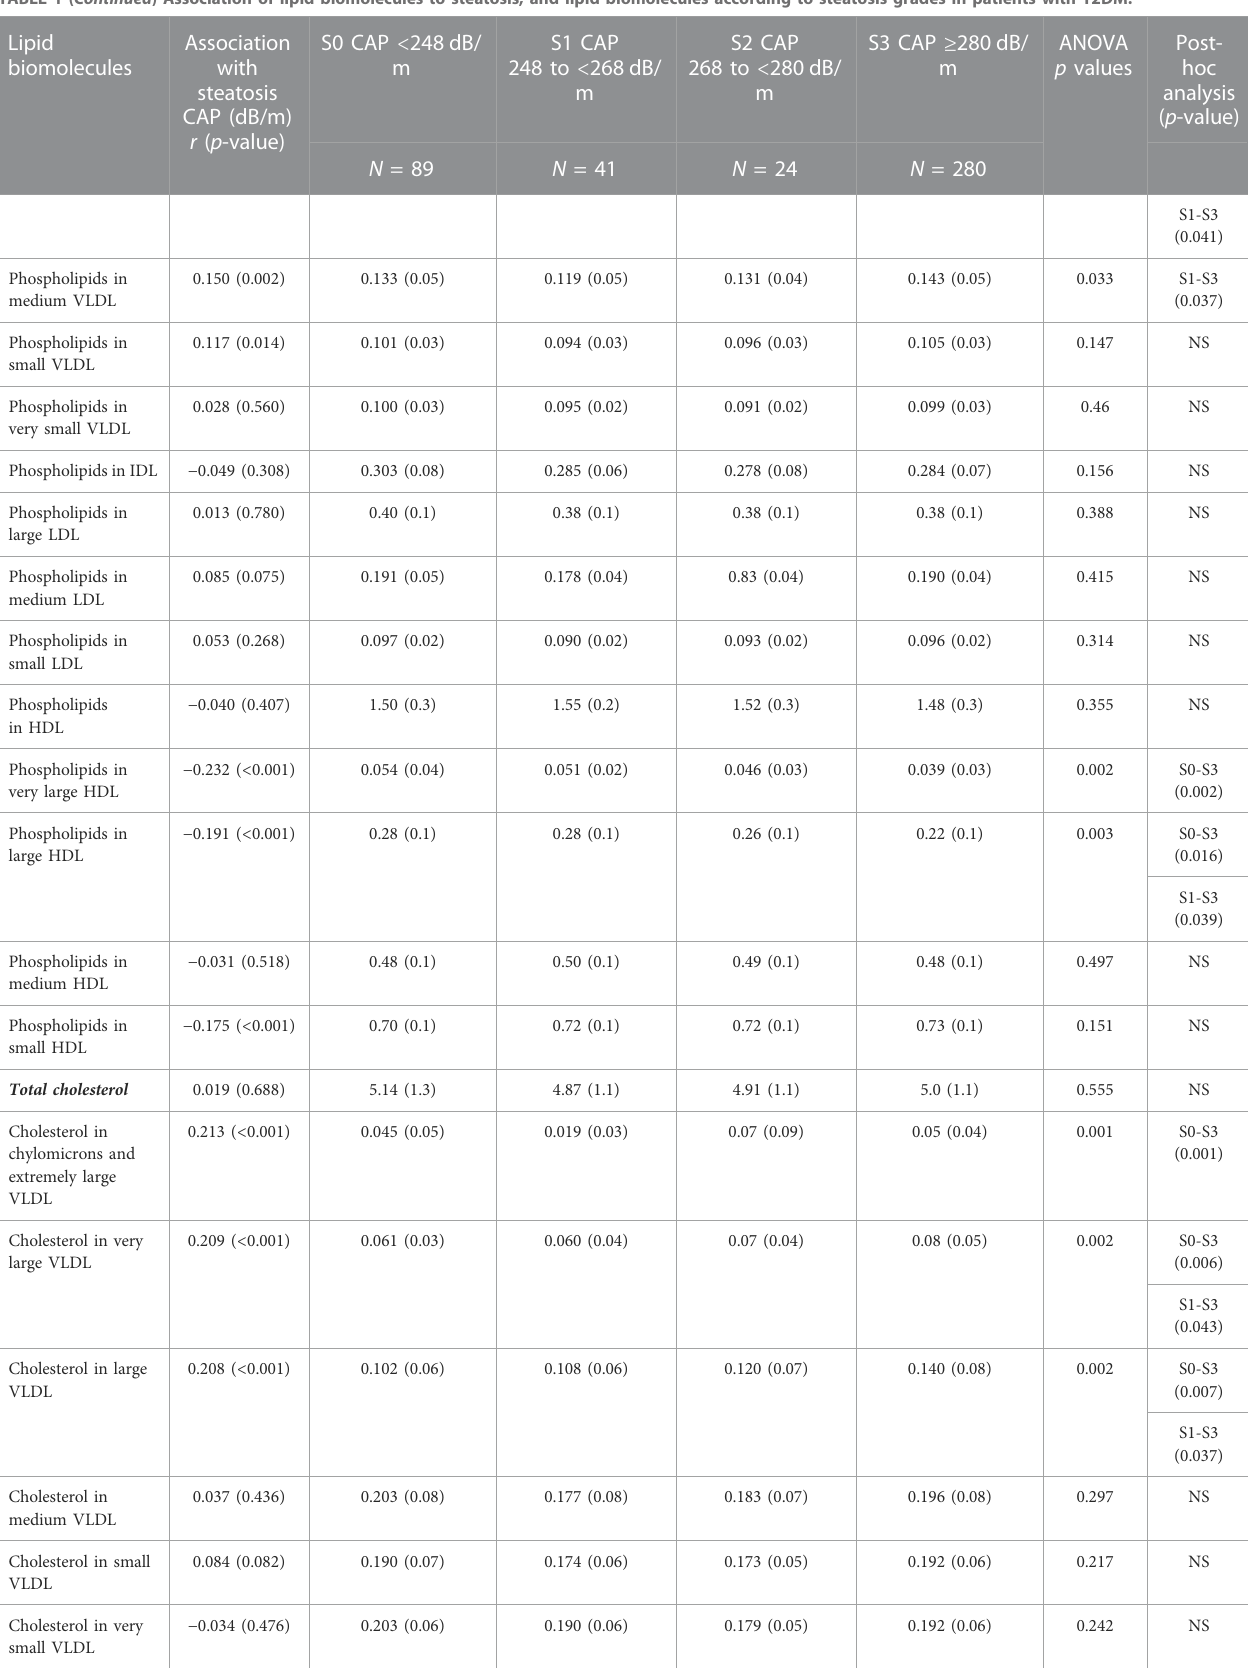
TABLE 1 ( Continued ) Association of lipid biomolecules to steatosis, and lipid biomolecules according to steatosis grades in patients with